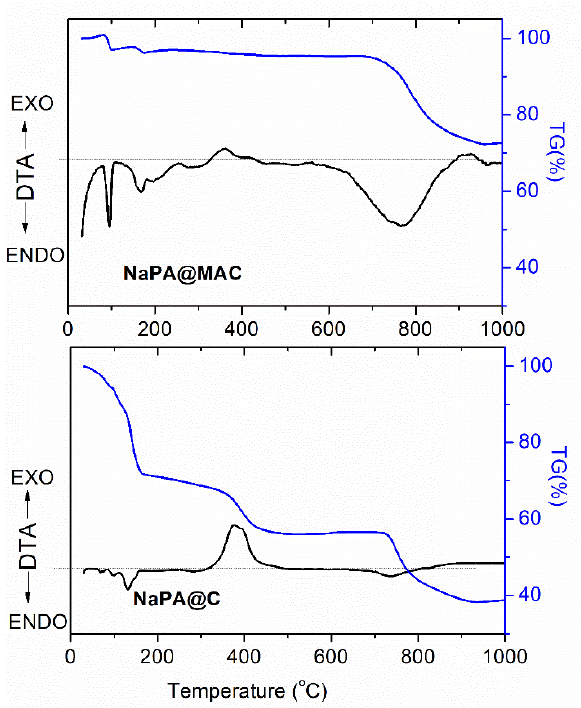
Figure 3. DTA and TGA curves of NaPA@C and NaPA@MAC Figure 3 . DTA and TGA curves of NaPA@C and NaPA@MAC samples.